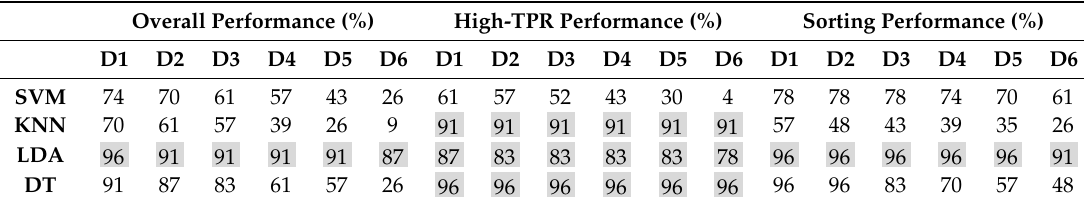
Table 5. The maximum cost reduction of ACS methods for achieving designated performance D1 to D6 with SVM, KNN, LDA and DT classifiers. The numbers marked with gray show situations in which there are big cost reductions but ACS methods actually work